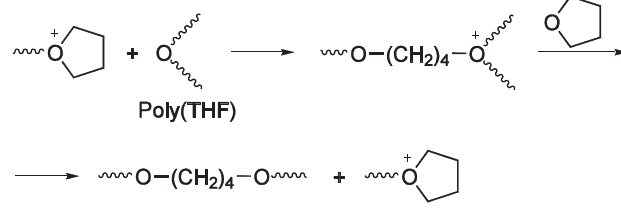
Figure 34. Transfer ( Termination) via an alkyl transfer